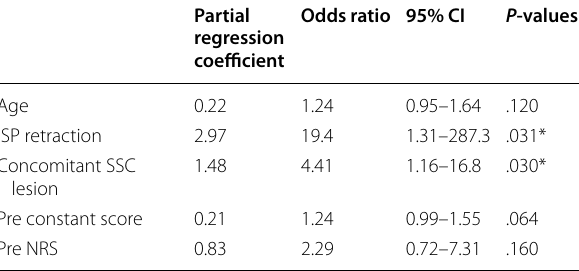
* Statistically significant between the healed and failed groups ( p <